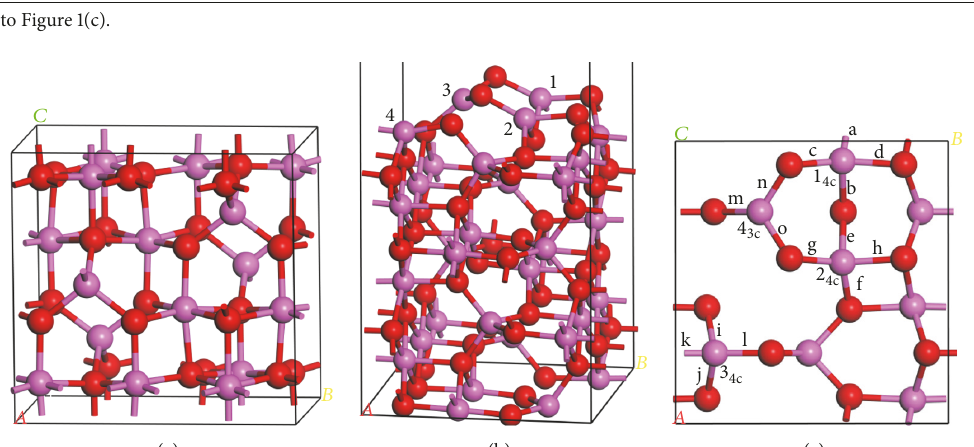
a Corresponding to Figure 1(c).